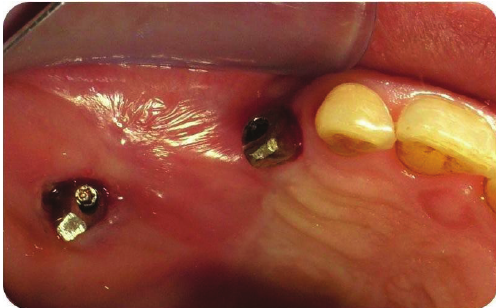
Figure 7: Intraoral view after implant abutments.